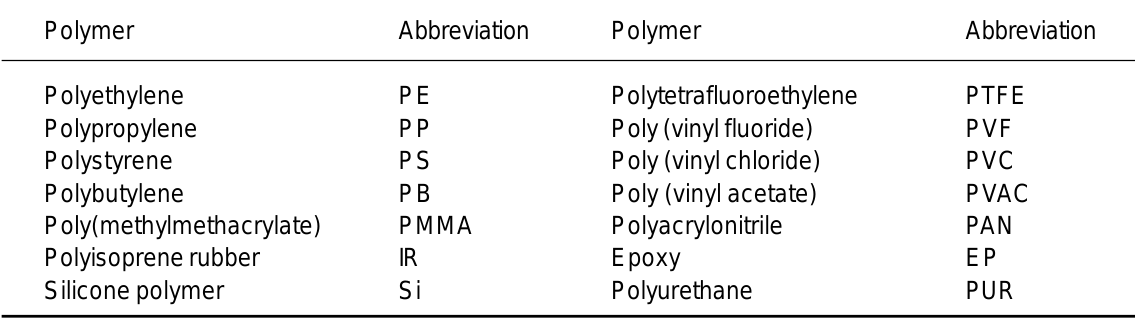
Table 2. Polymeric materials. Polymer